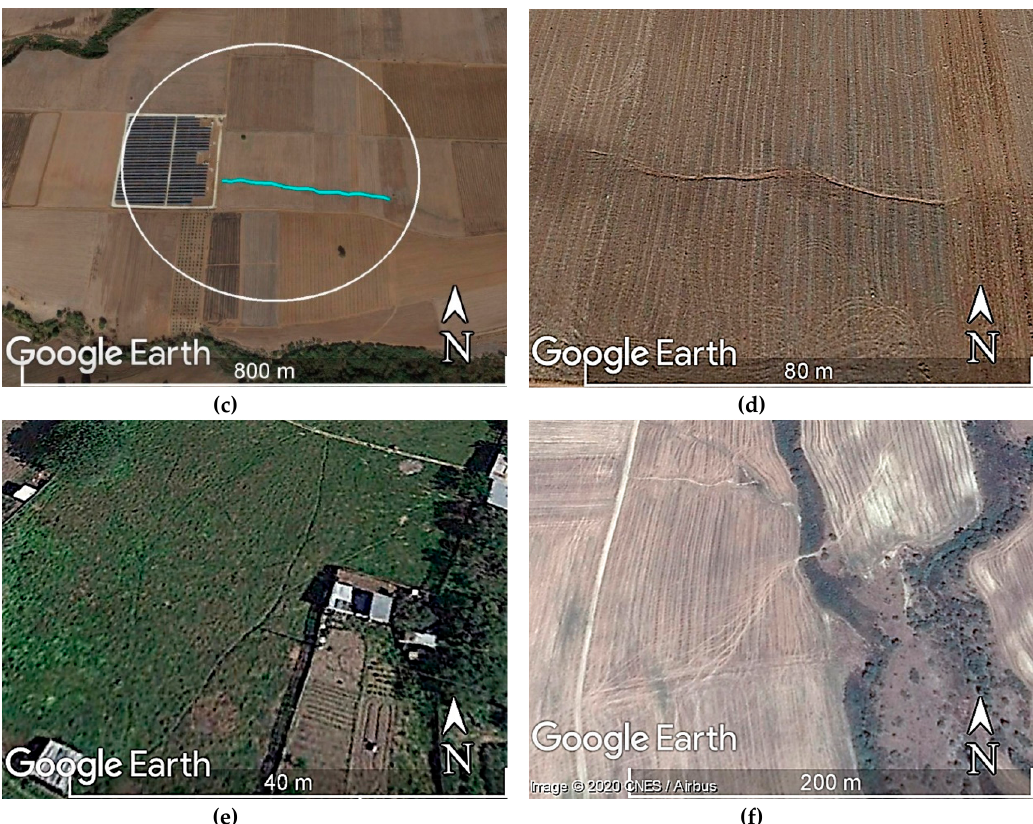
Figure 2. Examples of ephemeral gully detection. The sampled surfaces are denoted by white circles and gullies by cyan lines in the far views (geographic coordinates and image date in brackets) ( a ) sparse gullies formed towards a torrent in sloping olive plantation near Gerakini (40°18 ′ 56.41 ″ N/23°25 ′ 45.34 ″ E, 3 November 2016); ( b ) close view to case ( a ); ( c ) the longest identified gully near Almyros (39°10 ′ 55.07 ″ N/22°40 ′ 36.56 ″ E, 28 October 2013); ( d ) a close view to 0.6-m wide sections of the gully of case ( c ); ( e ) long parallel gullies in an arable field out of Sitia (35°11 ′ 42.82 ″ N/26°6 ′ 41.08 ″ E, 12 April 2013); ( f ) intensive rill and sheet erosion signs close to lake Doirani (41°8 ′ 26.07 ″ N/22°46 ′ 18.52 ″ E, 4 September 2013).